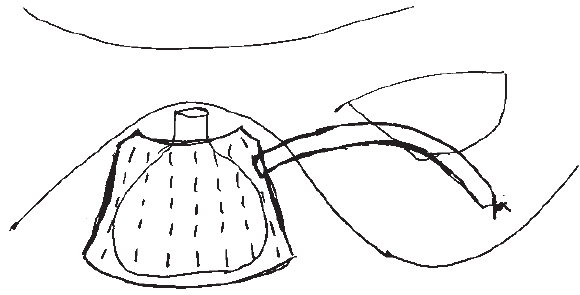
Figure 1 – Lateral mesh